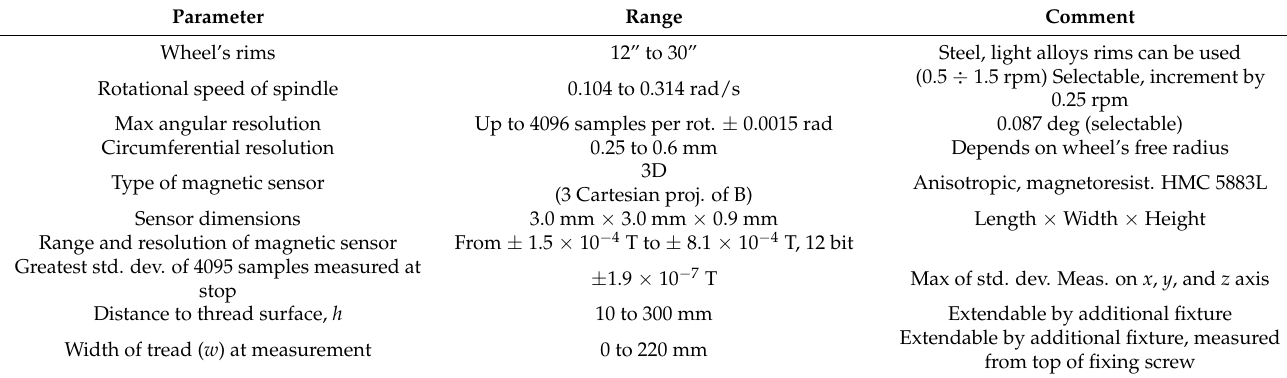
Table 2. Measuring device mechanical